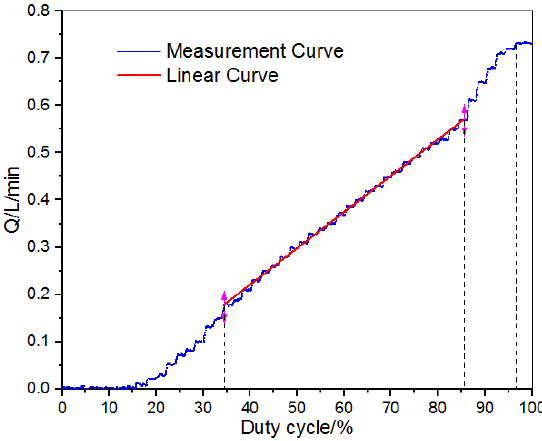
Figure 8. Signal–flow characteristic curve of miniature digital valve.